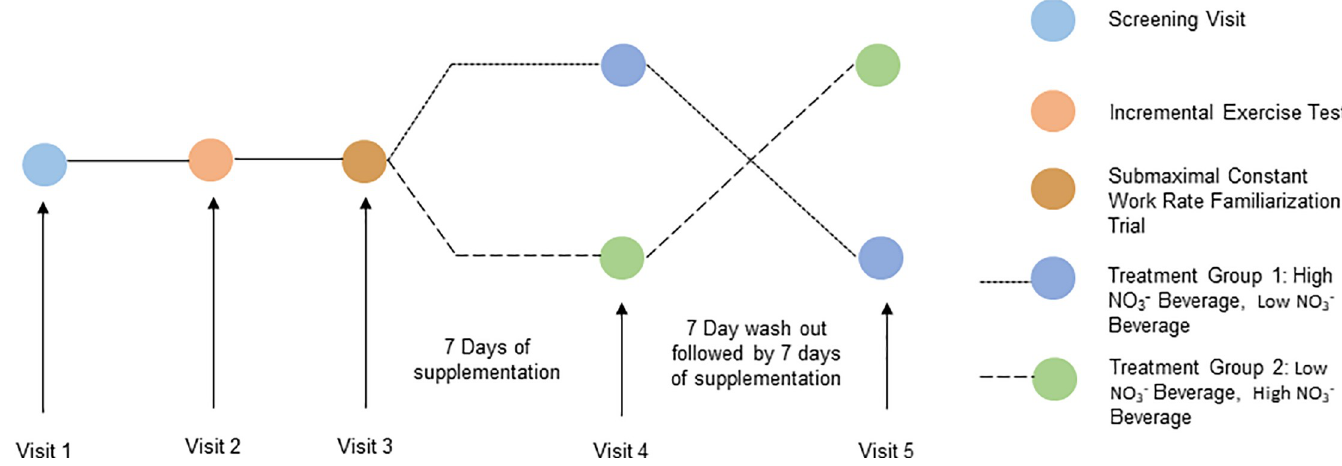
Fig 2. Schematic of study